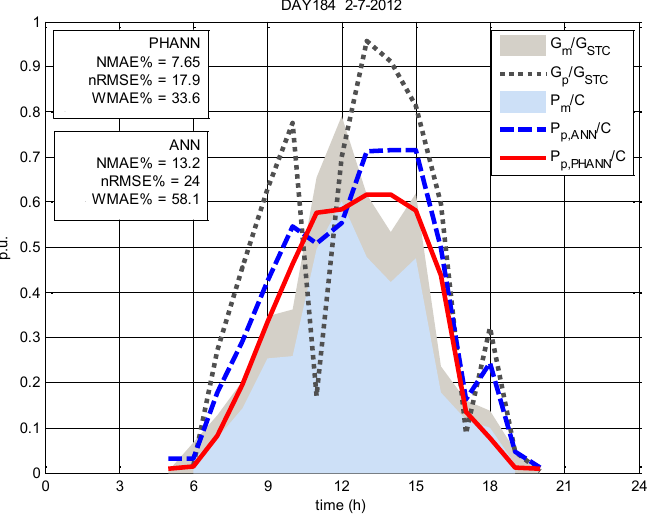
Figure 7. Power curves and daily error definitions applied to the forecasts in an unstable day. These trends are in agreement with the weather forecast provided by the Meteo service. Nevertheless it wasn’t able to forecast the precise time when the instability appeared.